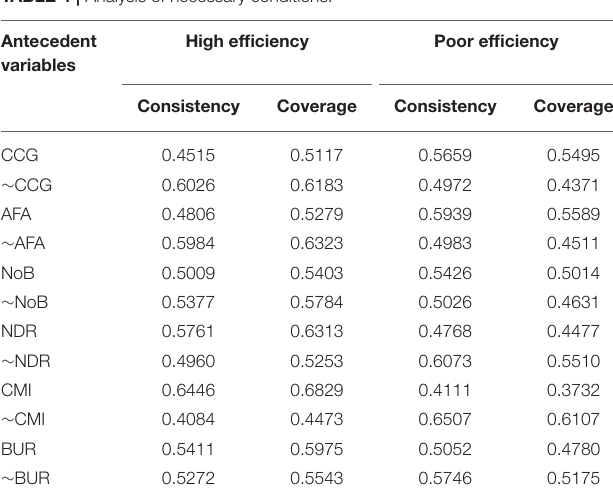
TABLE 4 | Analysis of necessary